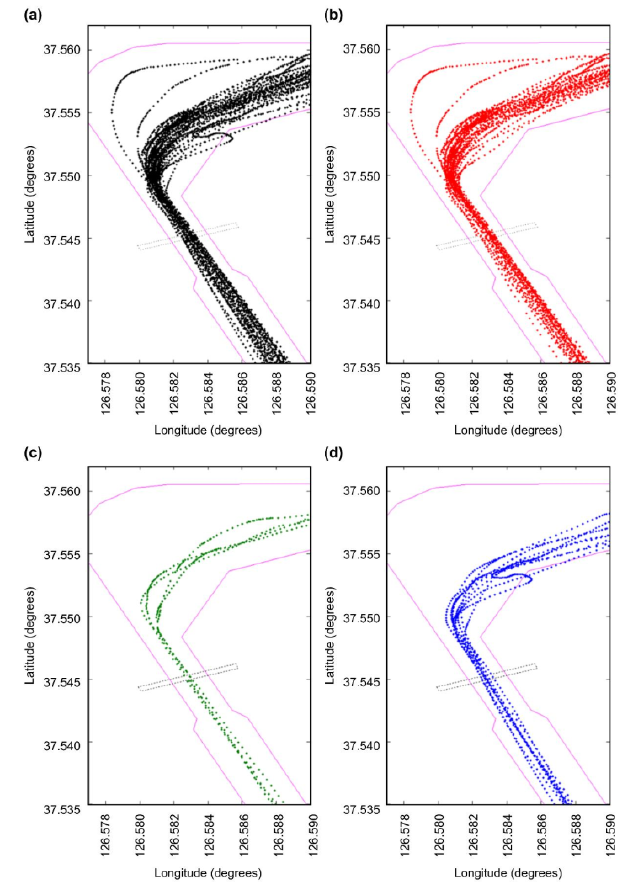
Figure 6. Track distribution according to tidal current: ( a ) all current situations; ( b ) flood current; ( c ) near slack; ( d ) ebb current.